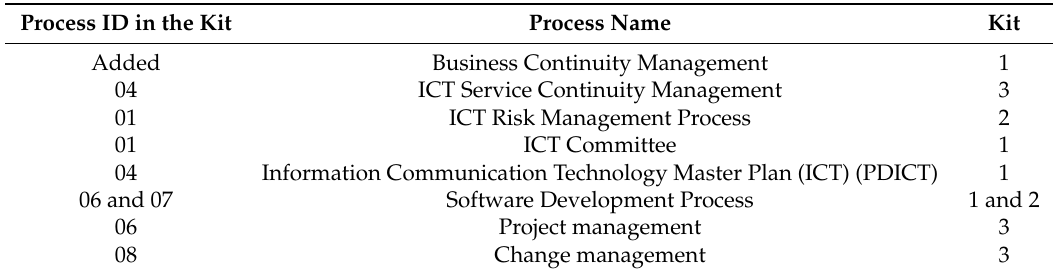
Table 4. Processes implemented in the